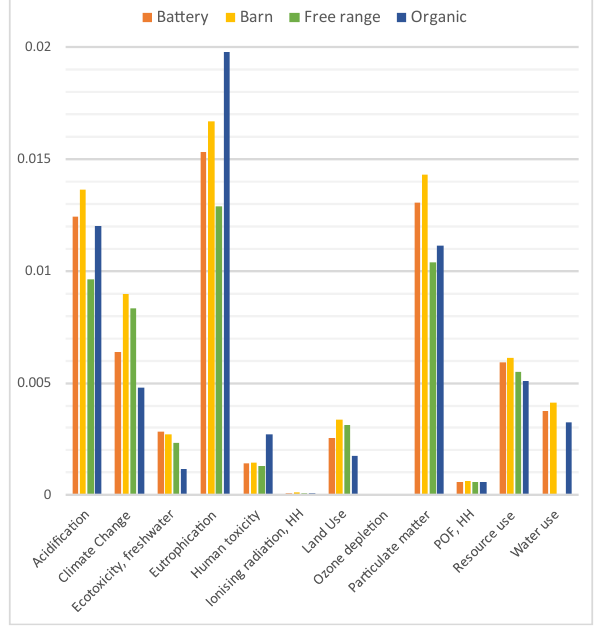
Figure 8. Normalized and weighted results for each impact category and laying systems for organic eggs that have a yield similar to battery eggs, using Environmental Footprint 3.0 for one kilogram of eggs.